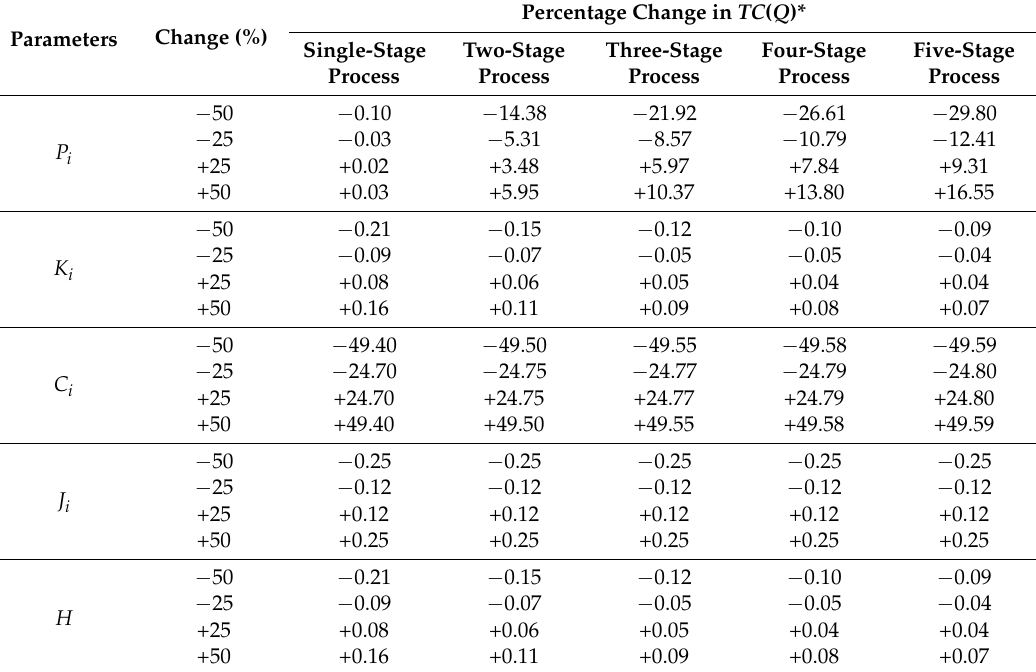
Table 4. Sensitivity analysis of key parameters for Example